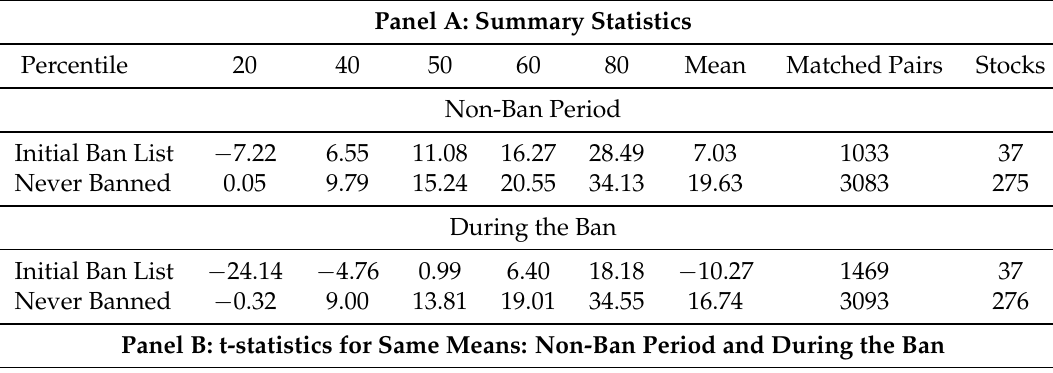
Table 8. The differences from the put–call parity. Panel A: Summary